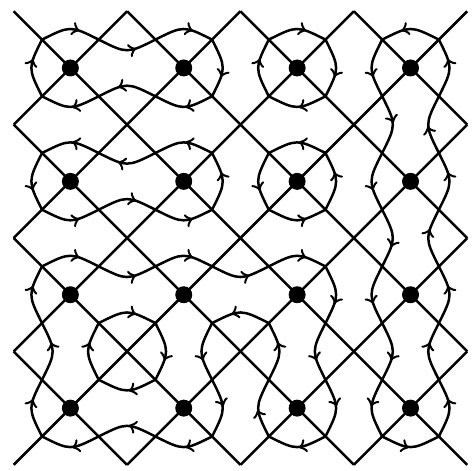
Figure 2 . A configuration of oriented loops. The oriented loop model becomes a six-vertex model, after summing over the loop splittings.